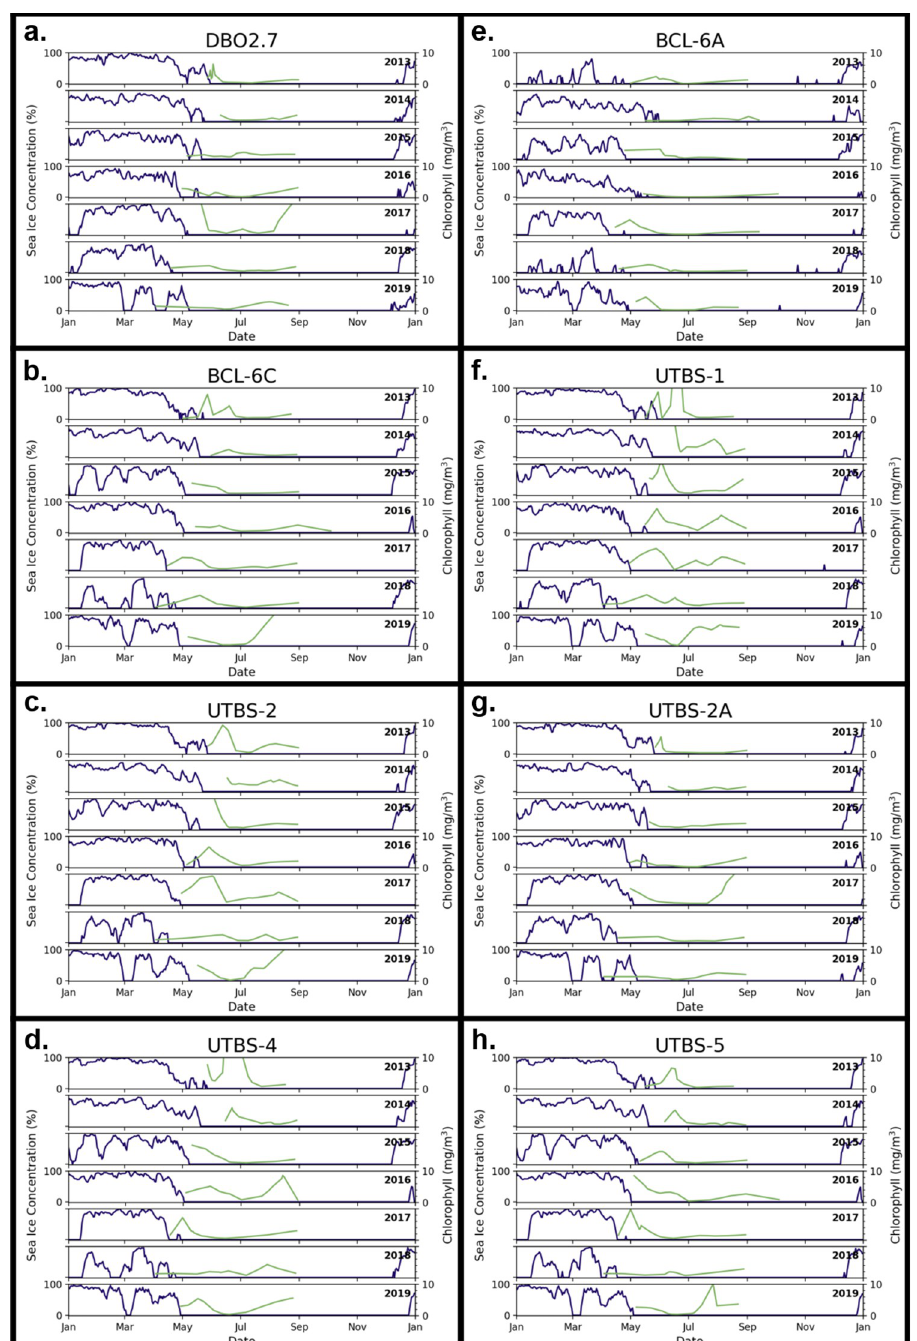
Fig 6. Daily sea ice concentrations (blue) and MODIS chlorophyll a (green) time series curves at the DBO2 stations. breakup resembled pre-2018 dates in DBO2 with some open water presence in March. Mean- while at DBO1, 2019 sea ice breakup dates remained anomalously early and increases in daily sea ice concentration were less striking than in spring 2018.